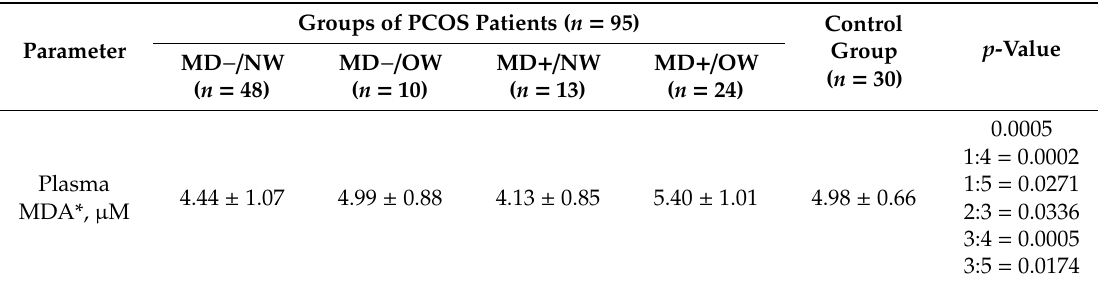
Table 4. Malondialdehyde (MDA) level in peripheral blood in adolescent girls with PCOS, grouped by BMI and metabolic